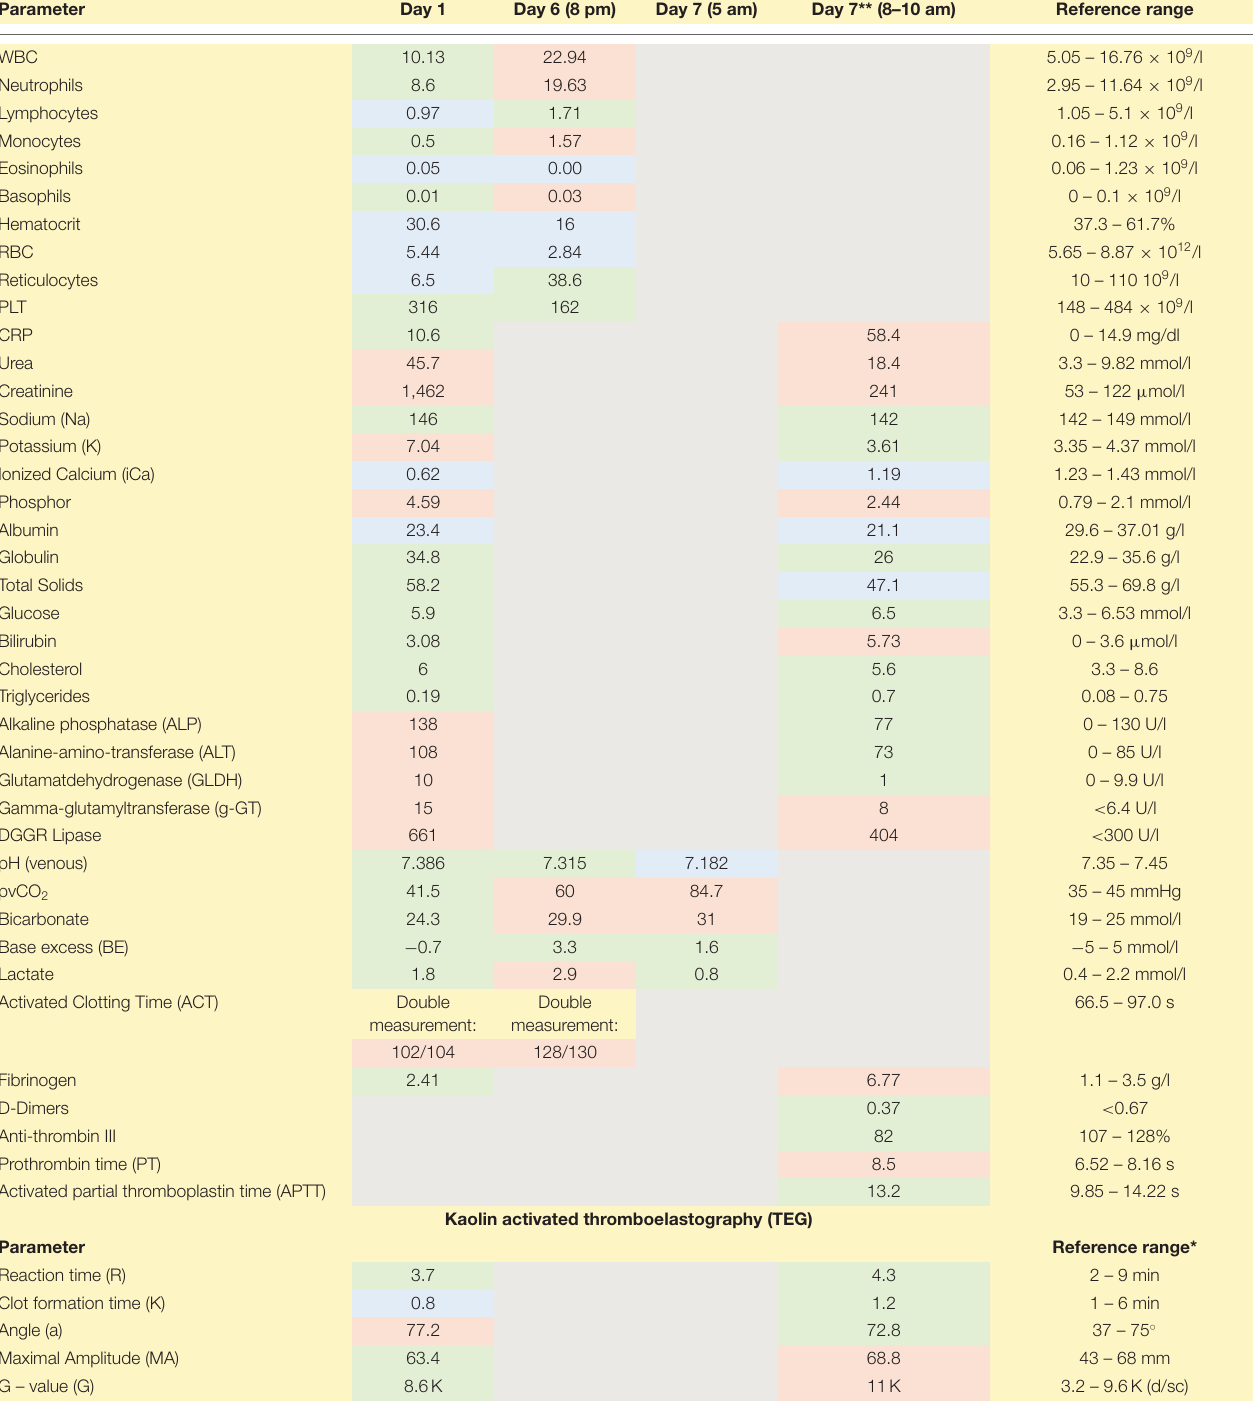
TABLE 1 | Summary of the blood results at